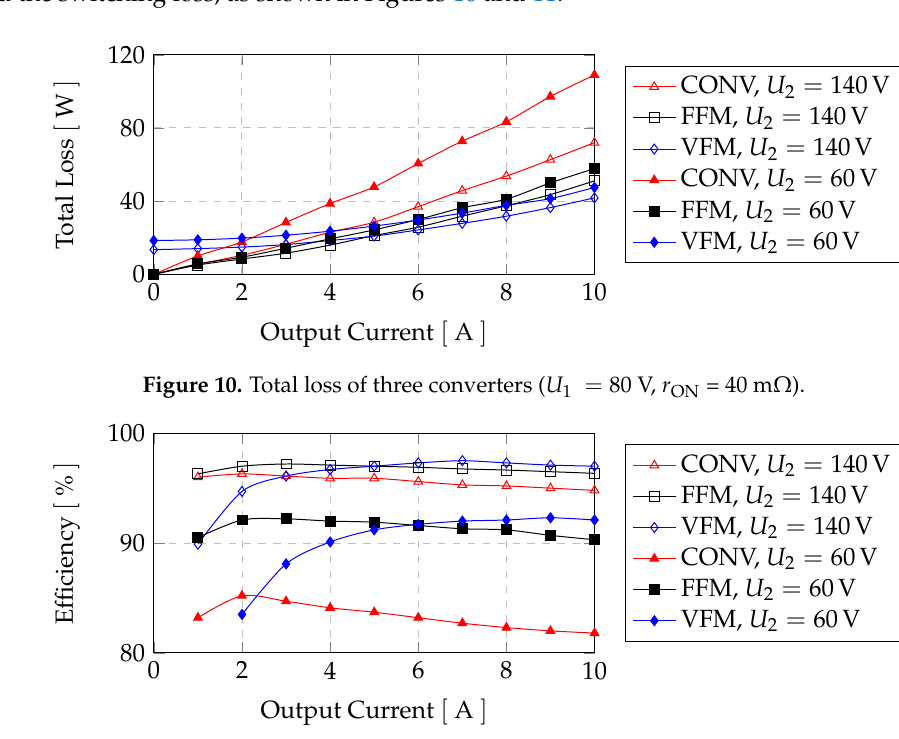
Figure 11. Power Efficiency of three converters ( U 1 = 80 V, r ON = 40 m Ω